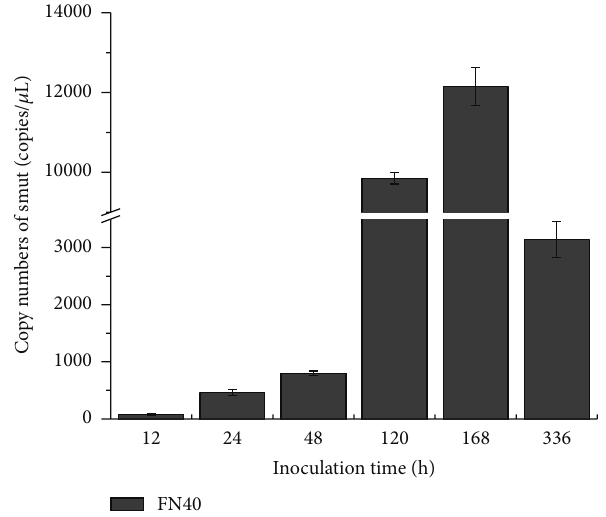
Figure5:Detectionofsmut-infectedFN40plantlets.Copynumbers of smut were calculated with the equation of the linear regression line. All data points mean ± SE ( 𝑛 = 3 ).